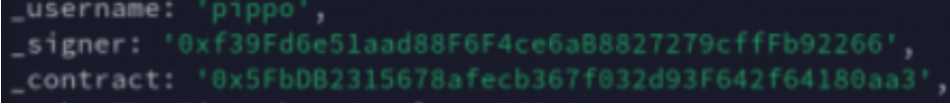
Figure 10. TwitterLink test data.